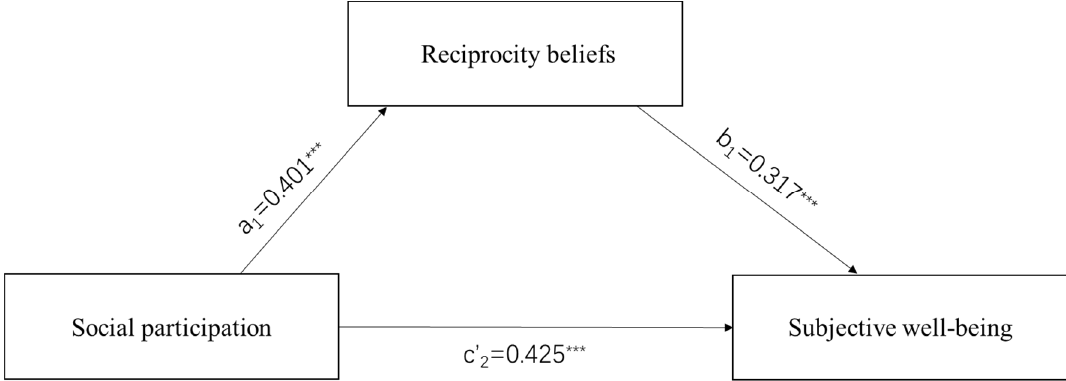
Figure 1. Mediation model of older men in Chengdu. *** p < 0.001.